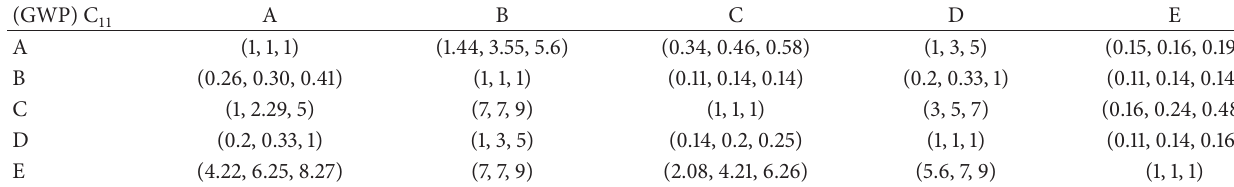
Table 4: Purposed options concerning GWP subcriteria.